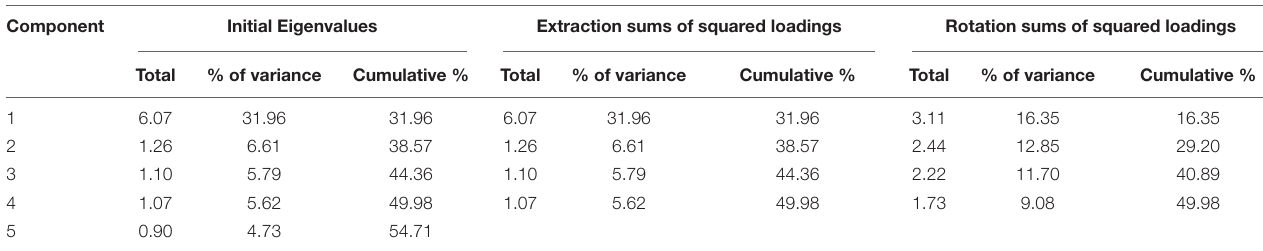
TABLE 3 | Total variance